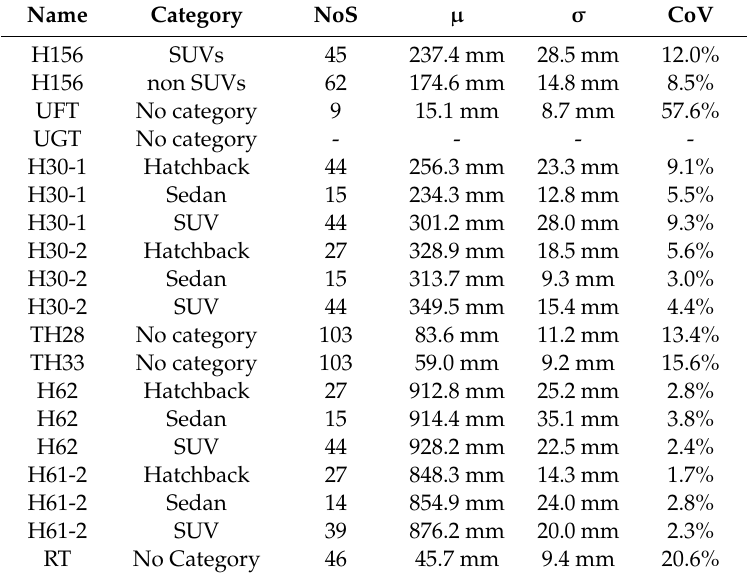
Table 4. Overview of the empirical values for the dimensional chain in the Z-direction.